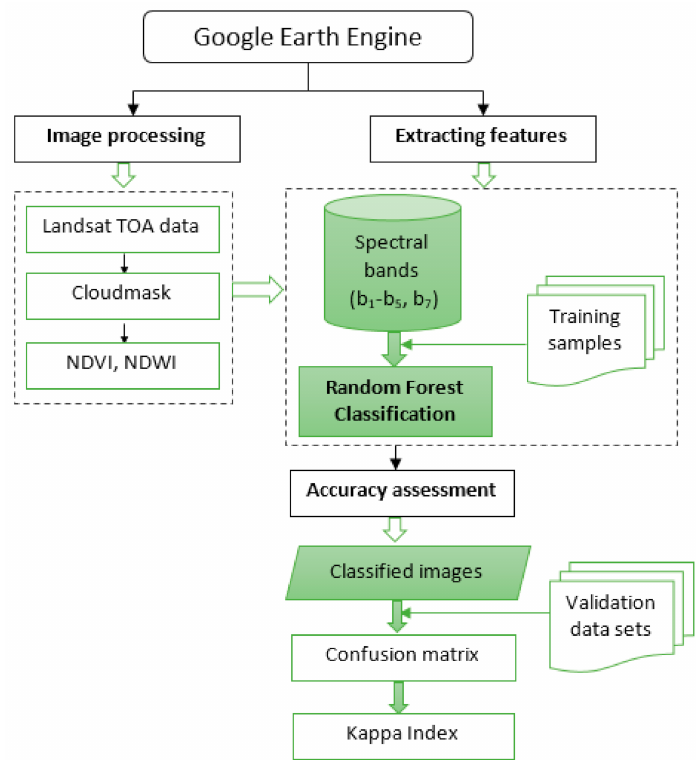
Figure 3. Methodology flowchart used for image